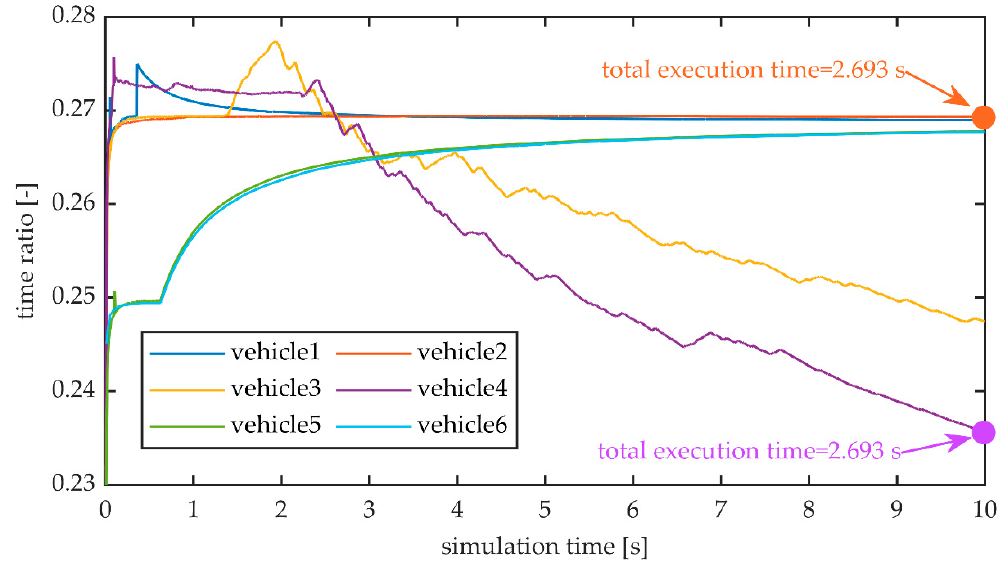
Figure 7. Thread execution time for the six concurrent simulations.